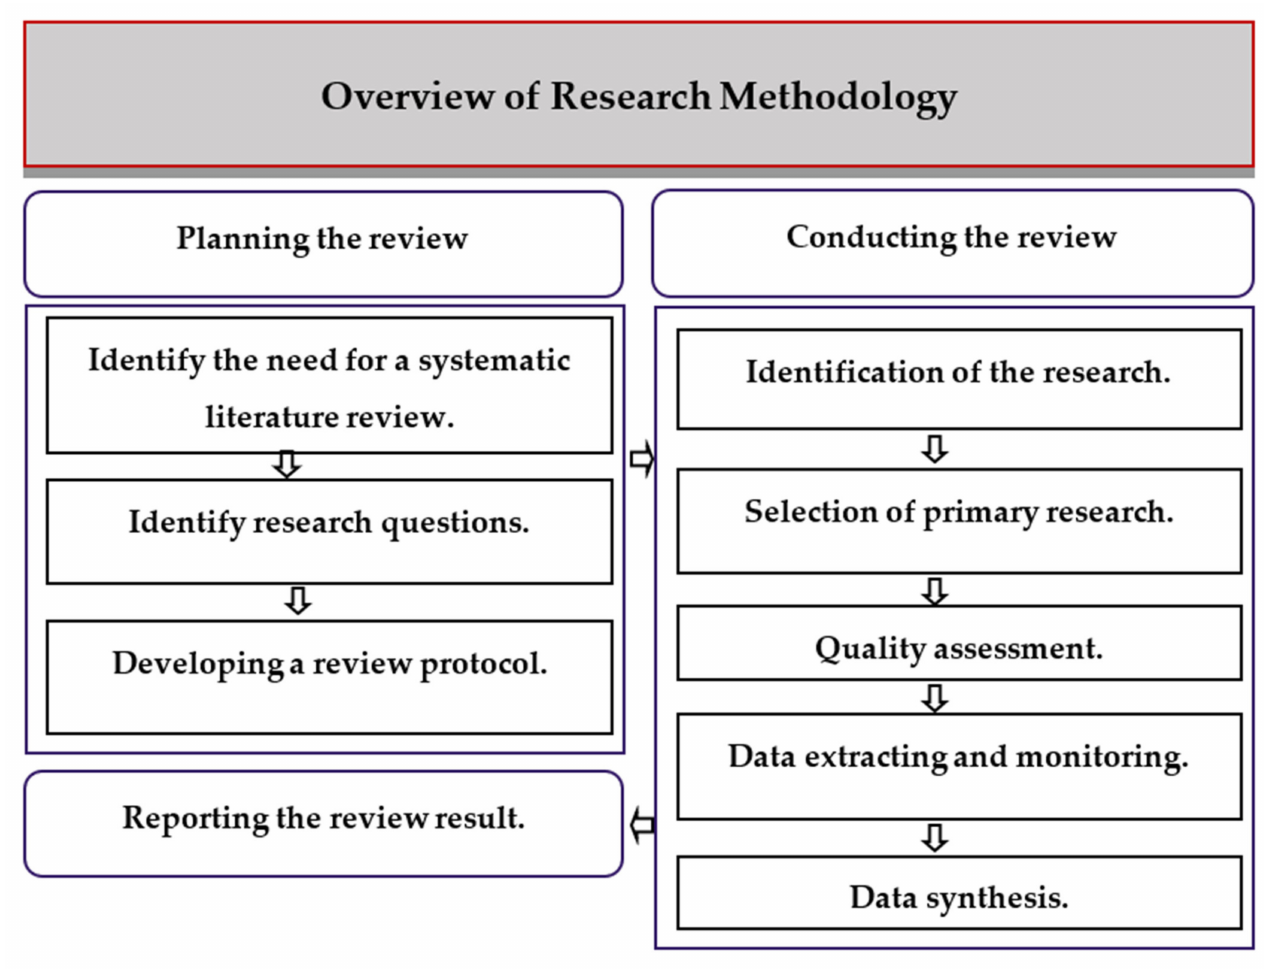
Figure 1. Literature review